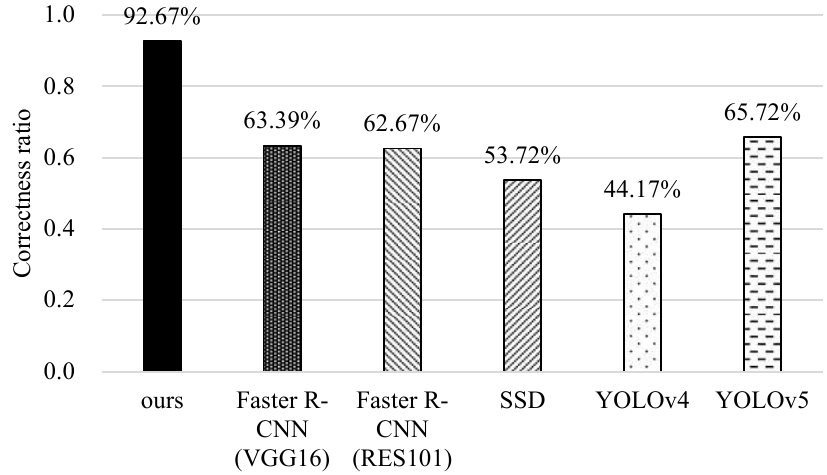
Figure 17. Comparisons of correctness ratios of different methods.